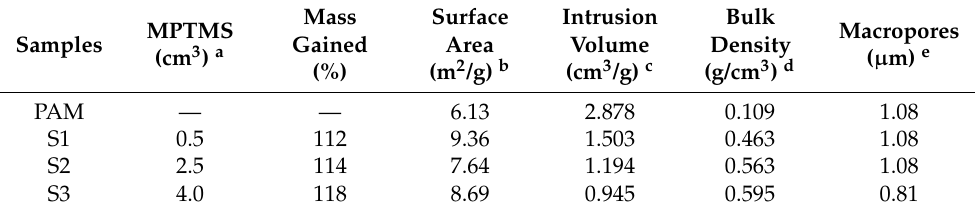
Table 1. Characterisation data for the MPTMS–PAM monolith composites.